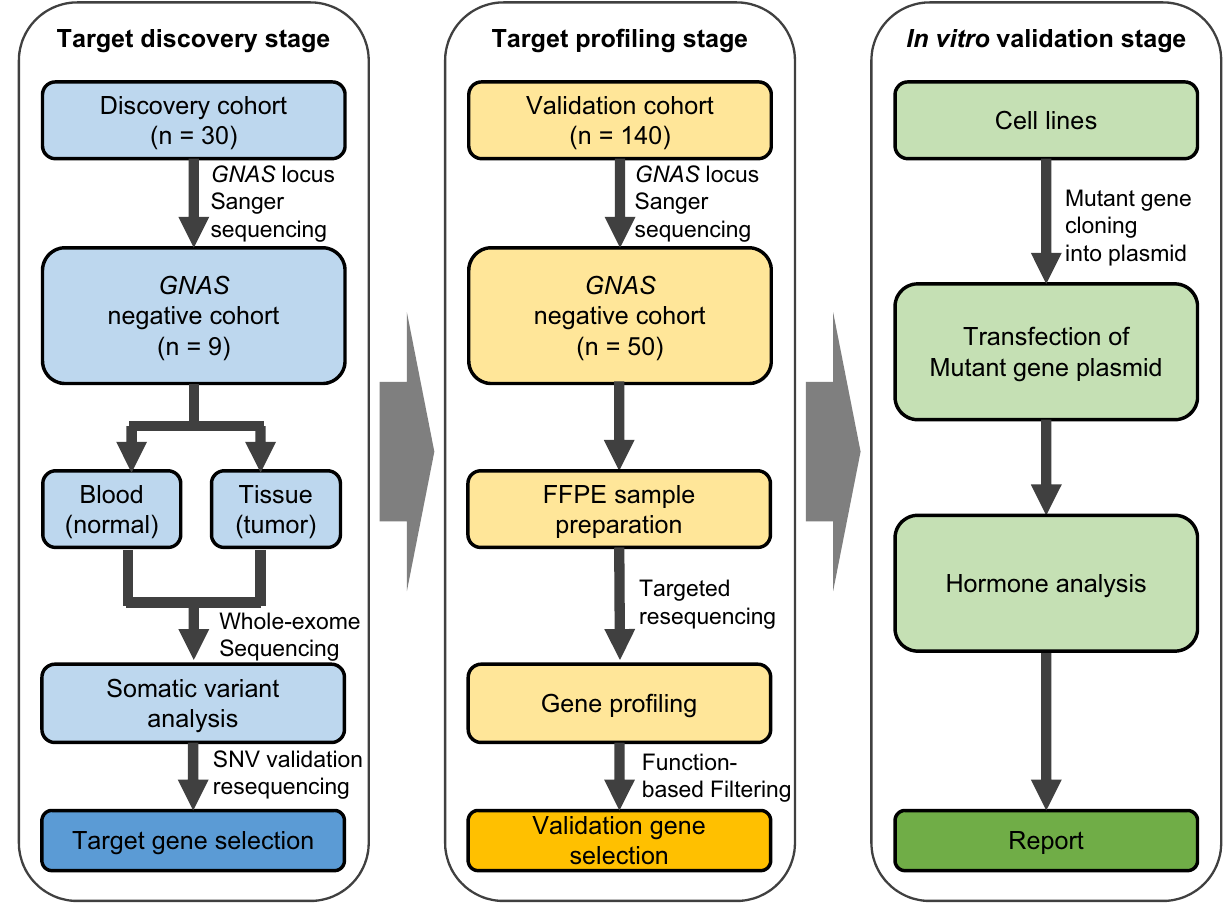
Figure 1. Schematic flow diagram of the current study. Genetic variants were investigated in three stages. In the first stage, “Target Discovery Stage,” blood and tissue samples of 30 patients were analyzed by Sanger sequencing, whole-exome sequencing (WES), and single nucleotide variant (SNV) validation resequencing, and genes with somatic variants were identified as target genes for profiling. In the second stage, “Target Profiling Stage,” target genes from 140 FFPE samples were analyzed by targeted resequencing, and relevant variants were selected for further validation. In the third stage, “In vitro Validation Stage,” selected variants were functionally examined by in vitro validation. Expression vectors containing variants were constructed and transfected into GH3 cell lines (drawn in Microsoft 365 Powerpoint; https:// www. micro soft. com/ ko- kr/ micro soft-